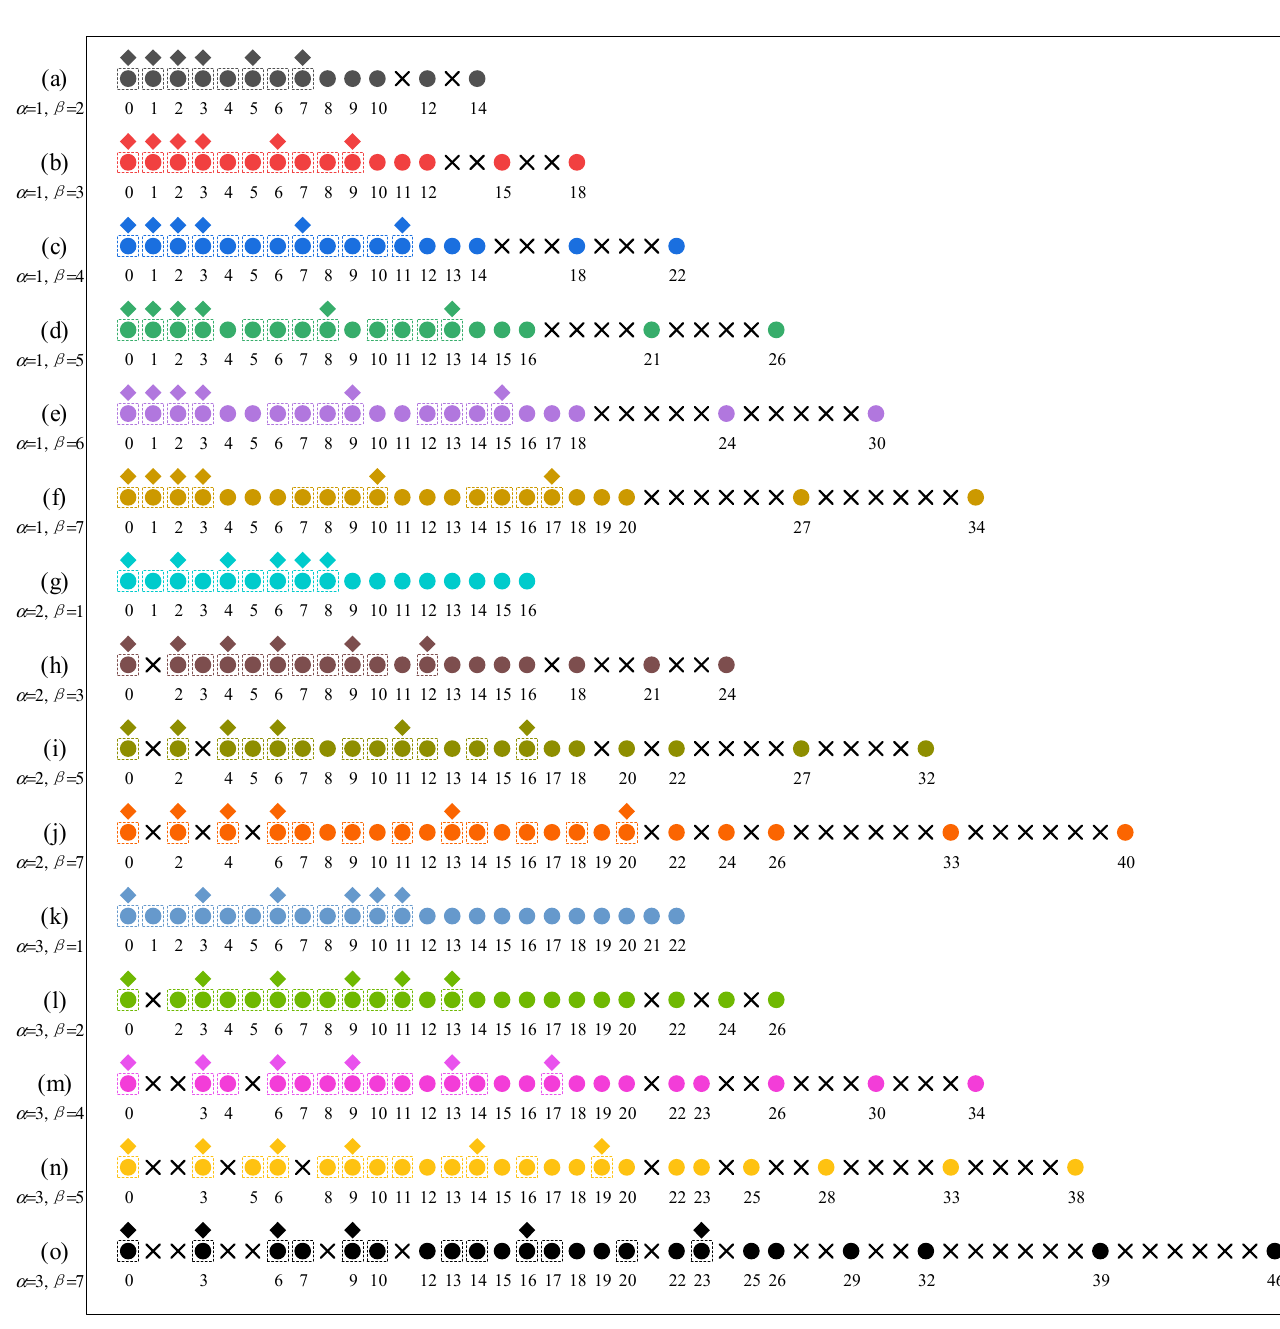
Figure 2. A family of six-sensor generalized nested arrays and their unique lags of the GNA-DCA and GNA-DSCA. Diamonds denote the sensor locations. Squares and circles indicate the unique lags in the GNA-DCA and GNA-DSCA, respectively, while crosses denote the hole locations.